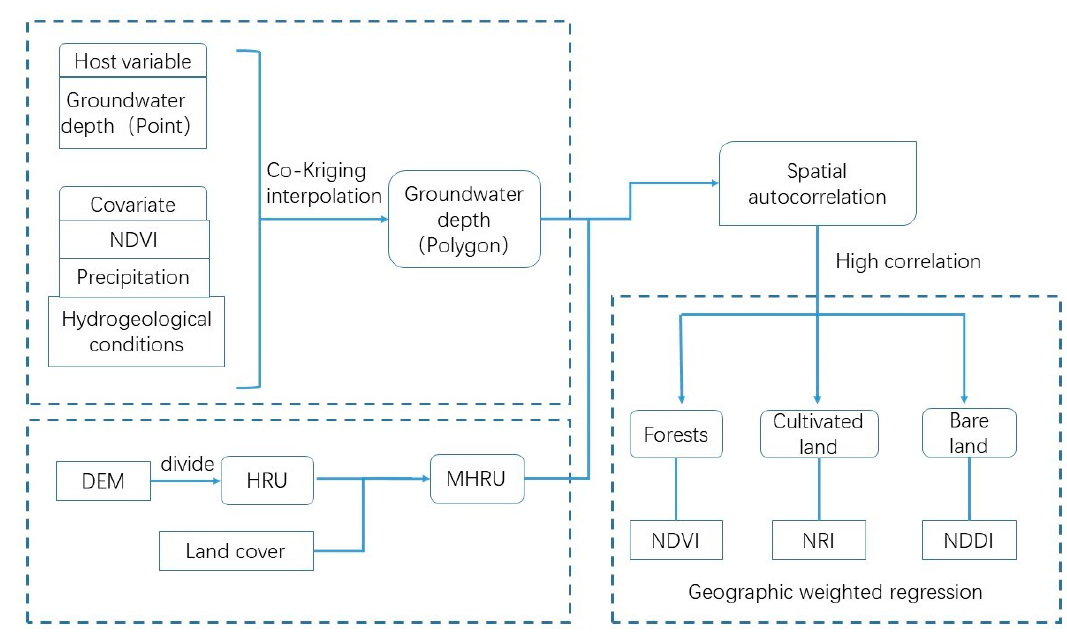
Figure 3. Processing flow chart.